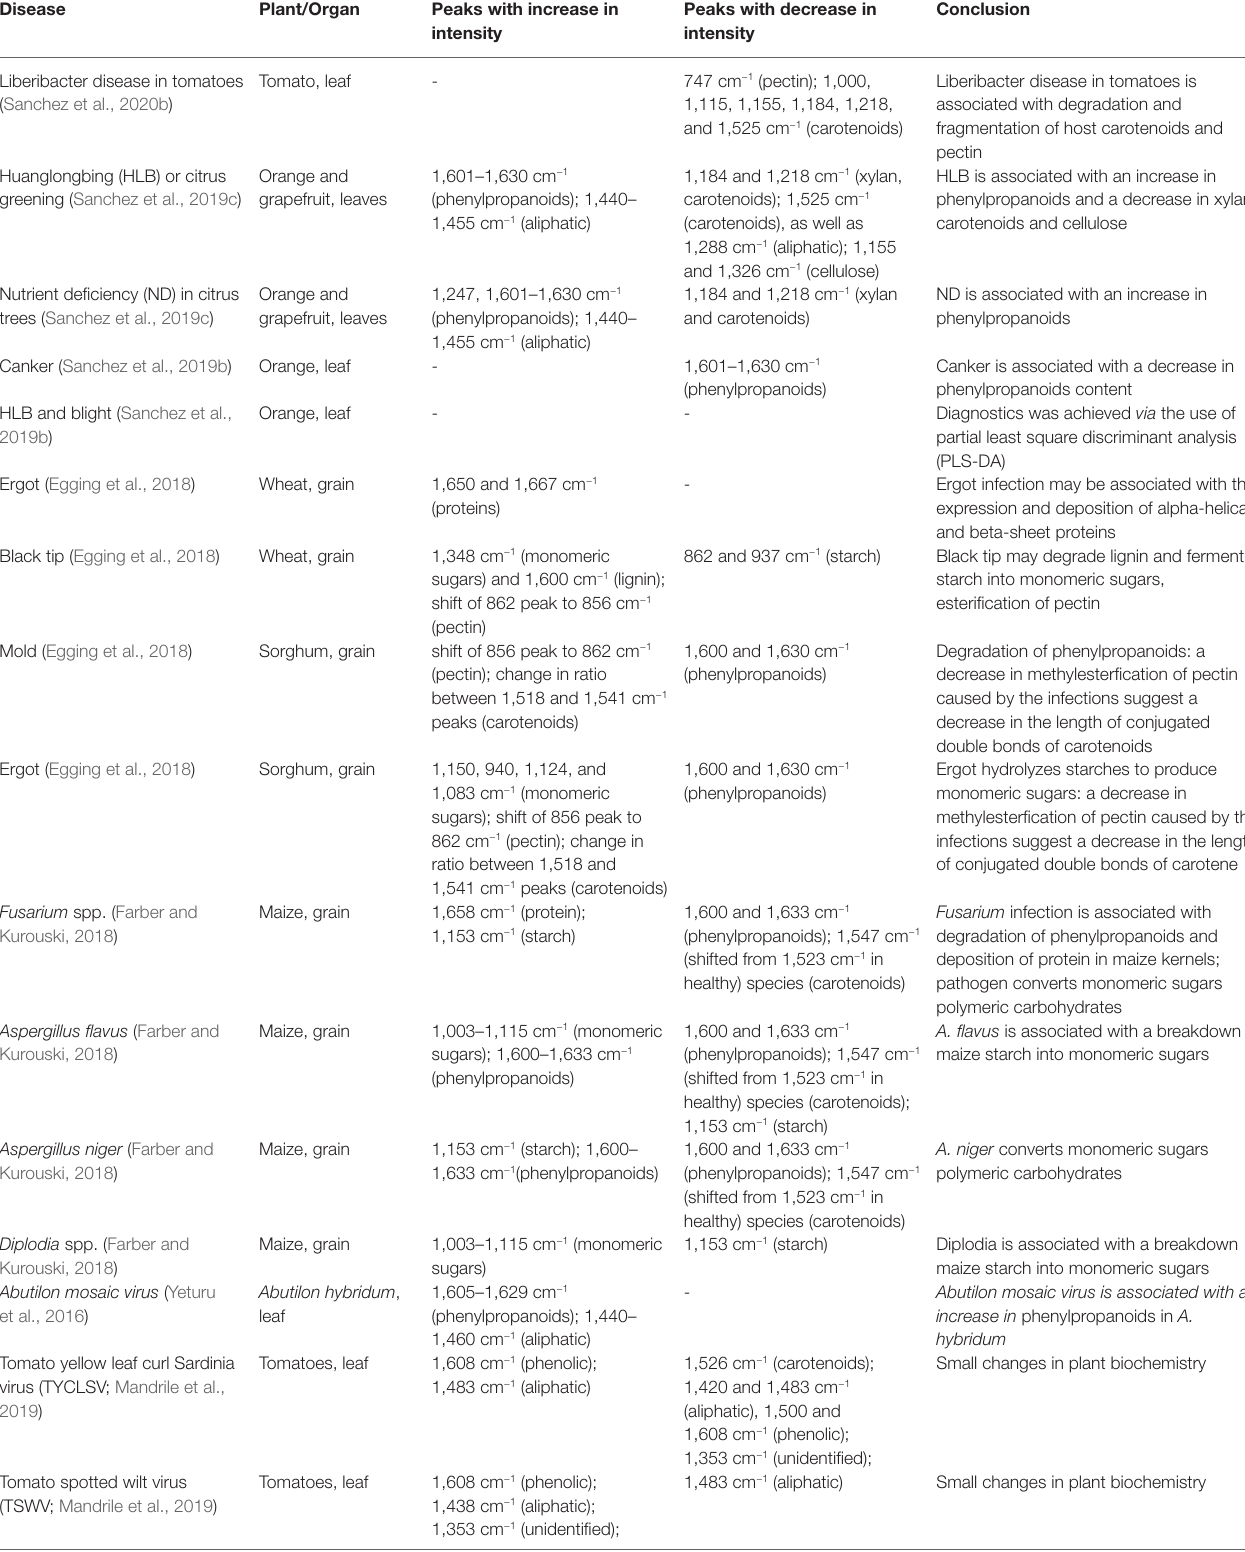
TABLE 2 | Summary of observed spectroscopic and corresponding biochemical changes in plants that are associated with certain